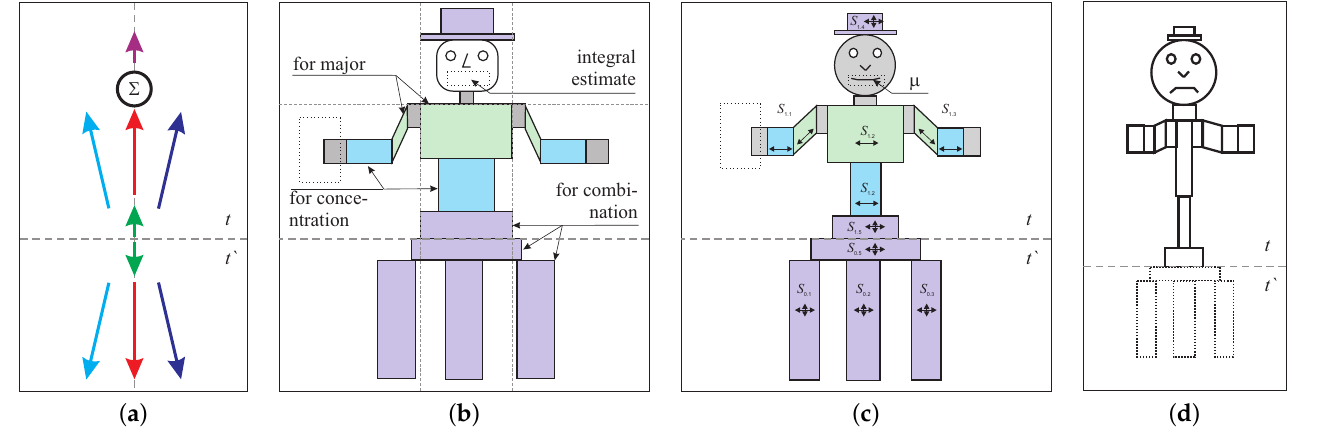
Figure 6. Stages of defining an image in the UGVA notation: sketch or framework ( a ), structural image ( b ), basic image ( c ), and the image of a particular object ( d ).